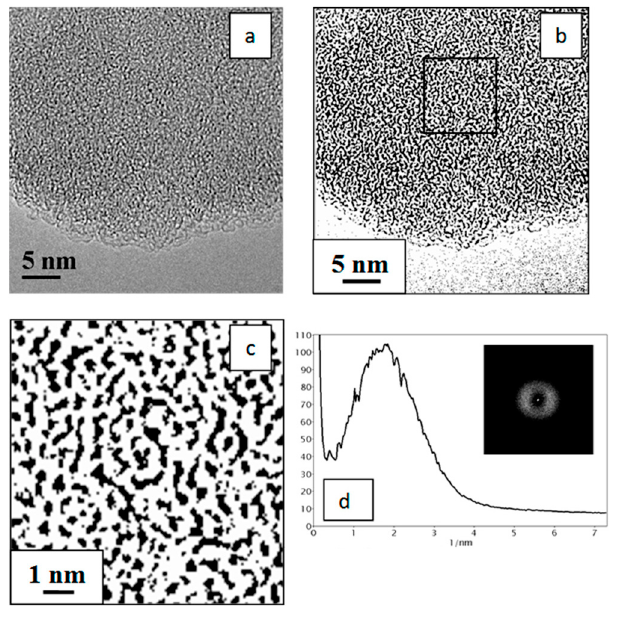
Figure 2. TEM image of the carbon material obtained by thermal treatment of dehydrochlorinated PVC at 400 ◦ C ( a ); the same TEM image in the binary form ( b ); its scaled-up central part marked by a square ( c ); and the radial contrast intensity profile (RCIP) ( d ), obtained by processing the FFT image that is displayed in the inset (units on the x axis correspond to the inverse distance between graphene layers,